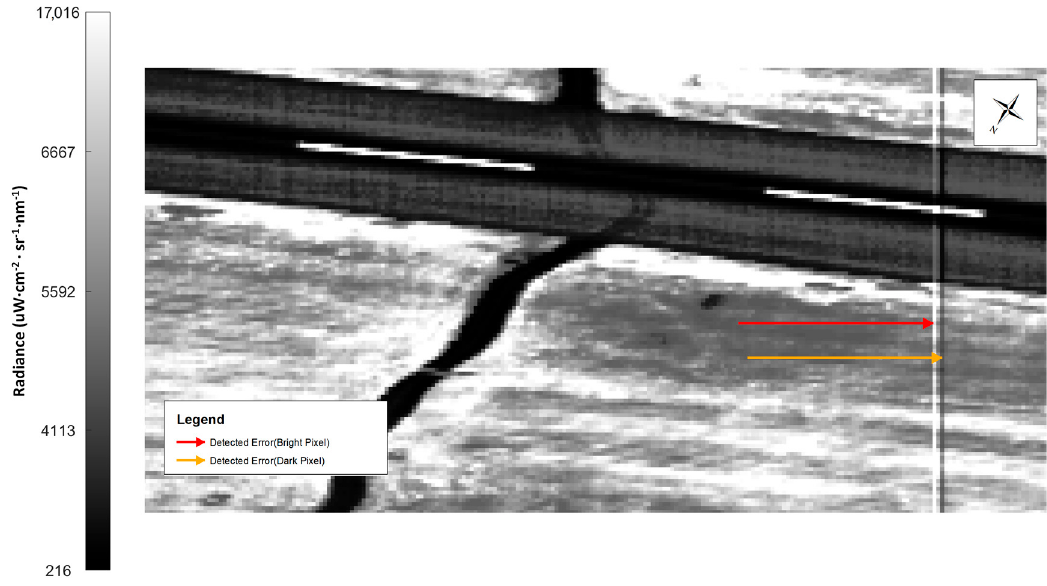
Figure 20. Histogram-equalized CASI (24 June with original processing) imagery at 744.653 nm. The image is zoomed in to display Columns 1248–1482 from left to right. The red and orange arrows point to the errors in Pixels 1454 and 1456 in the cross-track, respectively. These errors were visualized as a bright and dark vertical stripe.